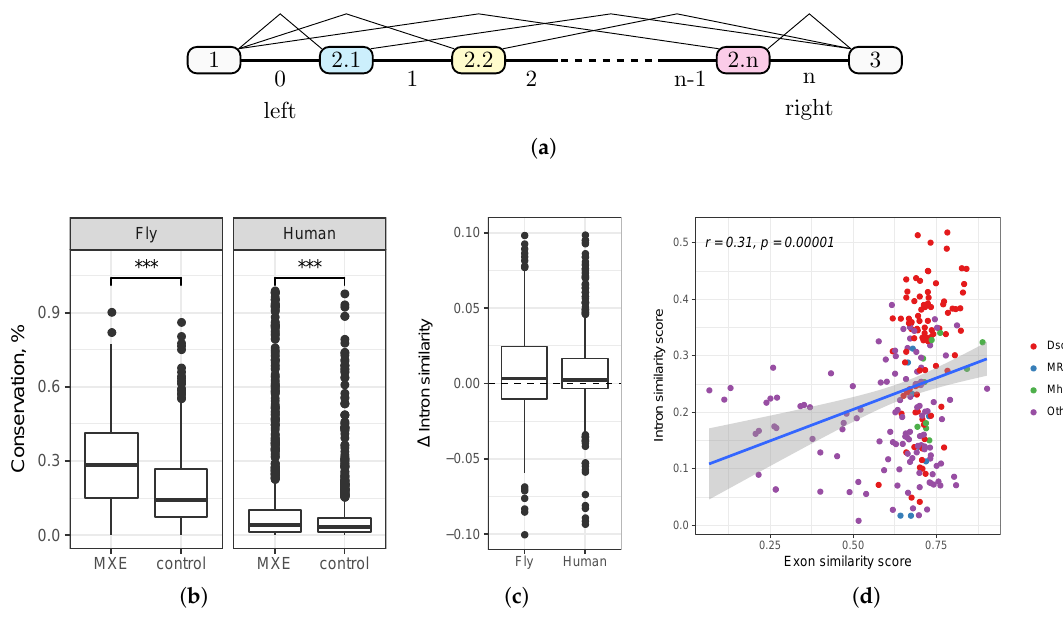
Figure 1. ( a ) A schematic representation of the mutually exclusive exon (MXE) cluster. Exons 1 and 3 are constitutive; exons 2.1,2.2, . . . ,2. n are mutually exclusive. The intervening introns are numbered from 0– n . The terminal flanking introns are called “left” and “right”, respectively. ( b ) The conservation rate in introns flanking MXE and in a random sample of introns flanking other exons (see the Methods). ( c ) The difference of similarity score ∆ σ = σ − σ 0 , where σ is the similarity score of consecutive introns i and i + 1 flanking MXE, and σ 0 is the respective similarity score in the control sample of introns matched by the length. ( d ) The similarity score of consecutive introns i and i + 1 vs. the similarity score of consecutive exons i and i +